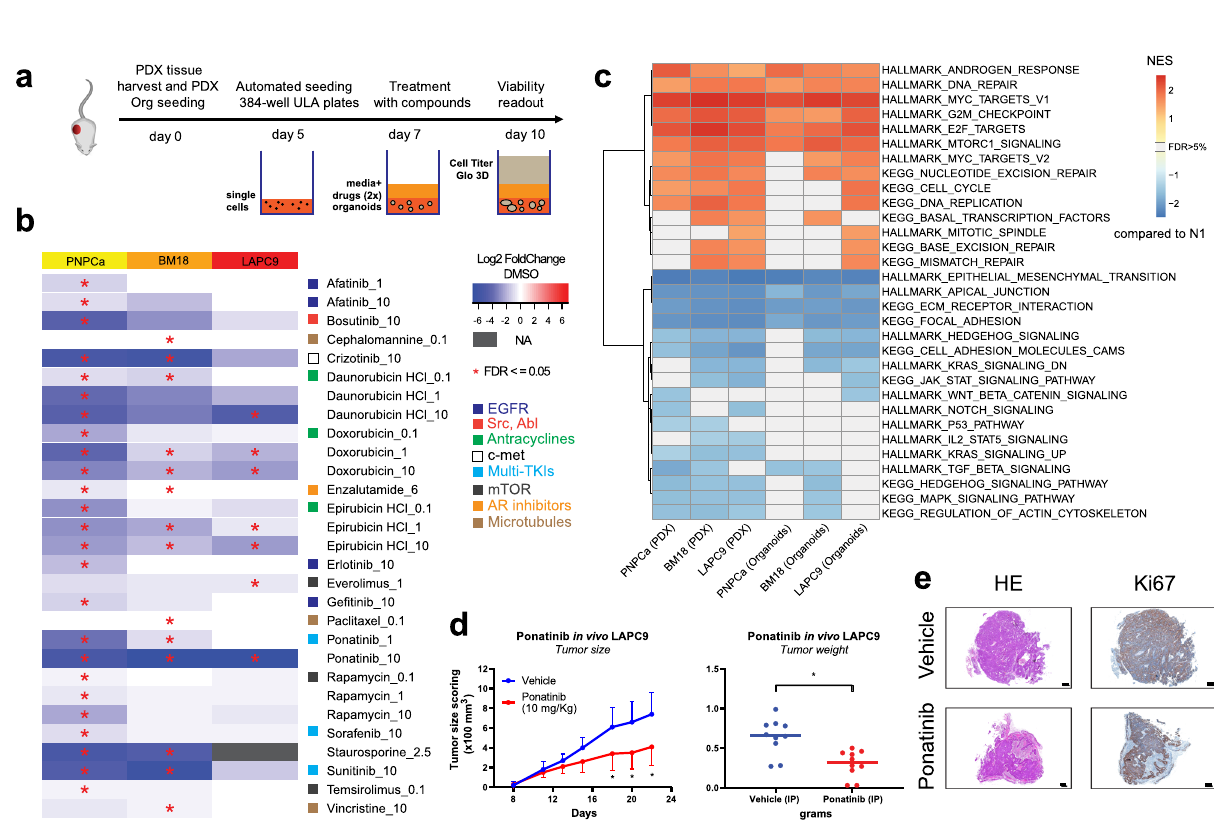
Fig. 4 Drug sensitivity of organoids representing different PCa stages and identi fi cation of novel compounds for repurposing use, based on medium- throughput organoid screens. a Scheme of experimental protocol for organoid drug screens. Created with BioRender.com. b Organoid drug screen heatmap of log 2 fold change viability values (over vehicle, for each PDX model) for PNPCa ( N = 4 replicates), BM18 ( N = 3), and LAPC9 ( N = 3). Negative log 2 values (plotted in blue) indicate potential drug candidates with impact on cell viability. Staurosporine was used as positive control. Statistically signi fi cant hits (FDR ≤ 0.05) are indicated with an asterisk. Hits with a signi fi cant effect on at least one model are reported, listed in alphabetical order and with effective dose indication on the right, in μ M. Medium-throughput automated drug screens, using selected FDA-approved compounds, were performed at Nexus Theragnostics platform. c Gene set enrichment analysis (GSEA) of PDXs tissue (PNPCa N = 3, BM18 N = 2, LAPC9 N = 2) and organoids (PNPCa N = 2, BM18 N = 2, LAPC9 N = 2). Enrichment scores of selected Hallmark and KEGG (C2) pathways with FDR < 0.05 derived from differential expression analysis of each group of samples vs. the non-carcinoma control tissue from PNPCa clinical sample (N1). NES normalized enrichment score. d In vivo ef fi cacy by ponatinib treatment in subcutaneous LAPC9 PDX model. Tumor-bearing mice received intraperitoneally (IP) daily injections of vehicle or ponatinib (10 mg/kg) and mean tumor size scoring (×100 mm 3 ) was plotted. Data are presented as mean ± SD, N = 10 independent tumor samples per treatment group); Two-way ANOVA with Sidak correction. * p = 0.029 (day 18), p = 0.012 (day 20), p = 0.016 (day 22). Tumor weight was assessed at endpoint and plotted as mean ± SD, N = 10 independent tumor samples per group; Two-tailed nested t -test. * p = 0.015. e Representative histology of LAPC9 PDX tumors from the vehicle and ponatinib groups, collected at endpoint. HE, hematoxylin and eosin, Ki67 proliferation marker. Scale bars, 0.5 castration-resistant LAPC9 to mTOR inhibition by everolimus. All models were sensitive to the tested anthracyclines (doxor- ubicin, daunorubicin, and epirubicin) targeting DNA replication and to the tyrosine kinase inhibitor ponatinib.